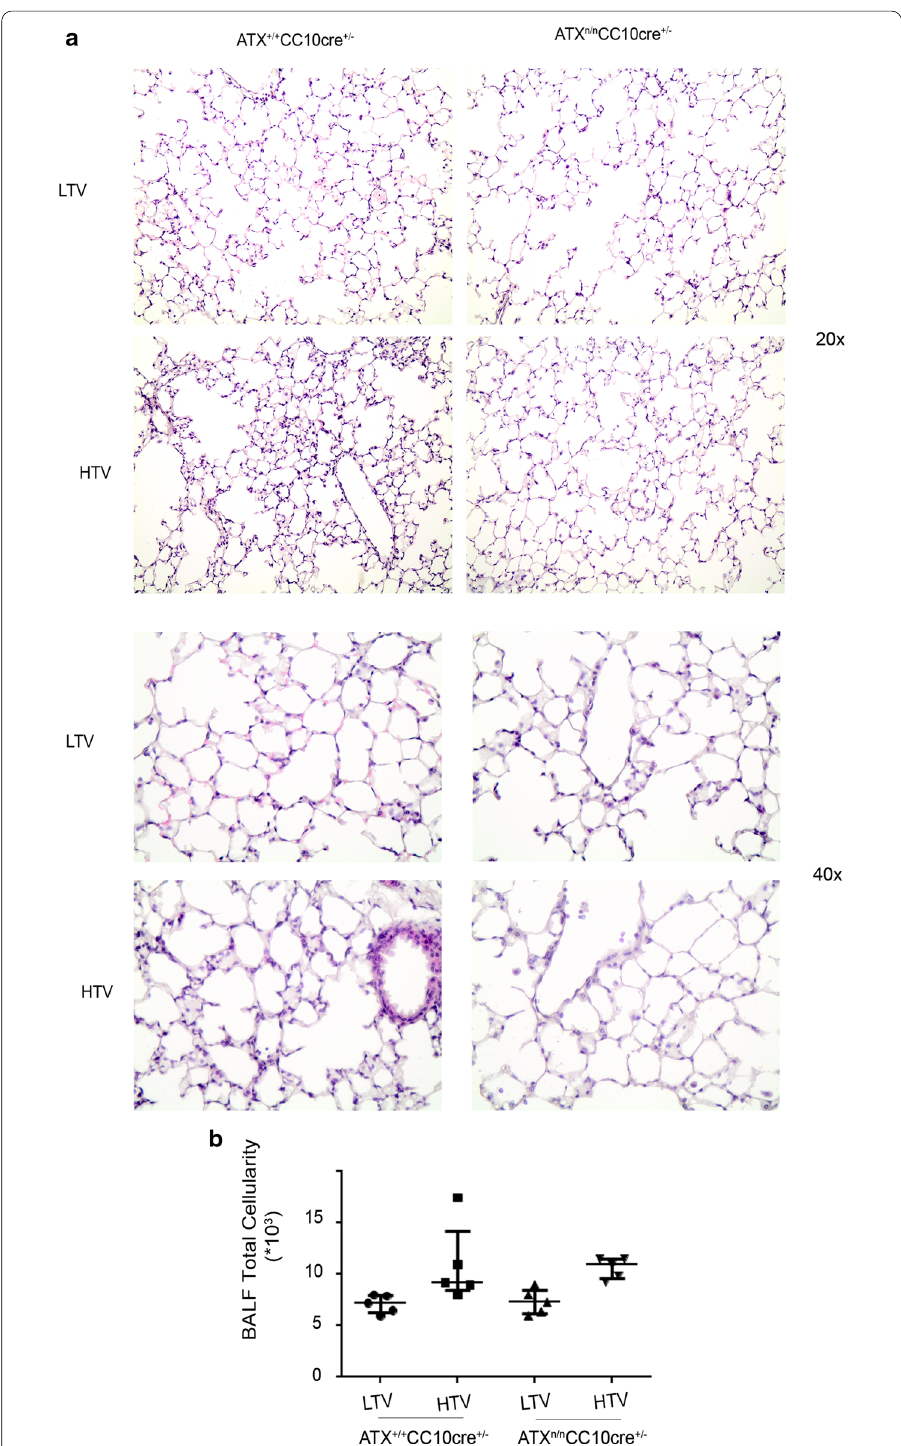
Fig. 4 Deletion of ATX from bronchial epithelial cells improves lung histopathology. a Representative hematoxylin and eosin-stained lung sections at 20 *Statistically significant differences ( P < 0.05), n LTV low tidal volume, HTV high tidal volume, BALF bronchoalveolar lavage